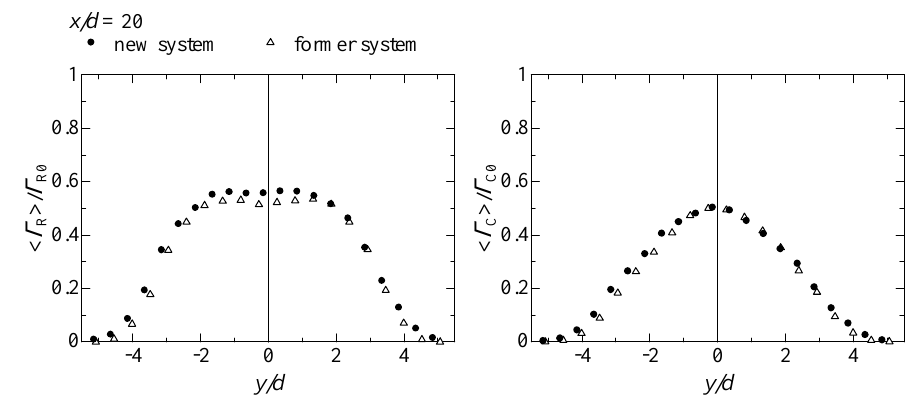
Fig. 10 The lateral profiles of the normalized mean concentrations of product R, ⟨ (cid:0) R ⟩ =(cid:0) R0 , and non-reactive species C, ⟨ (cid:0) C ⟩ =(cid:0) C0 , obtained by the new system ( (cid:15) ) and the former system ( △ ) at x = d = 20.